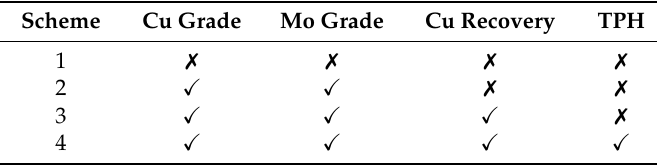
Table 2. Summary of schemes on simulated variables to be assessed on economic block